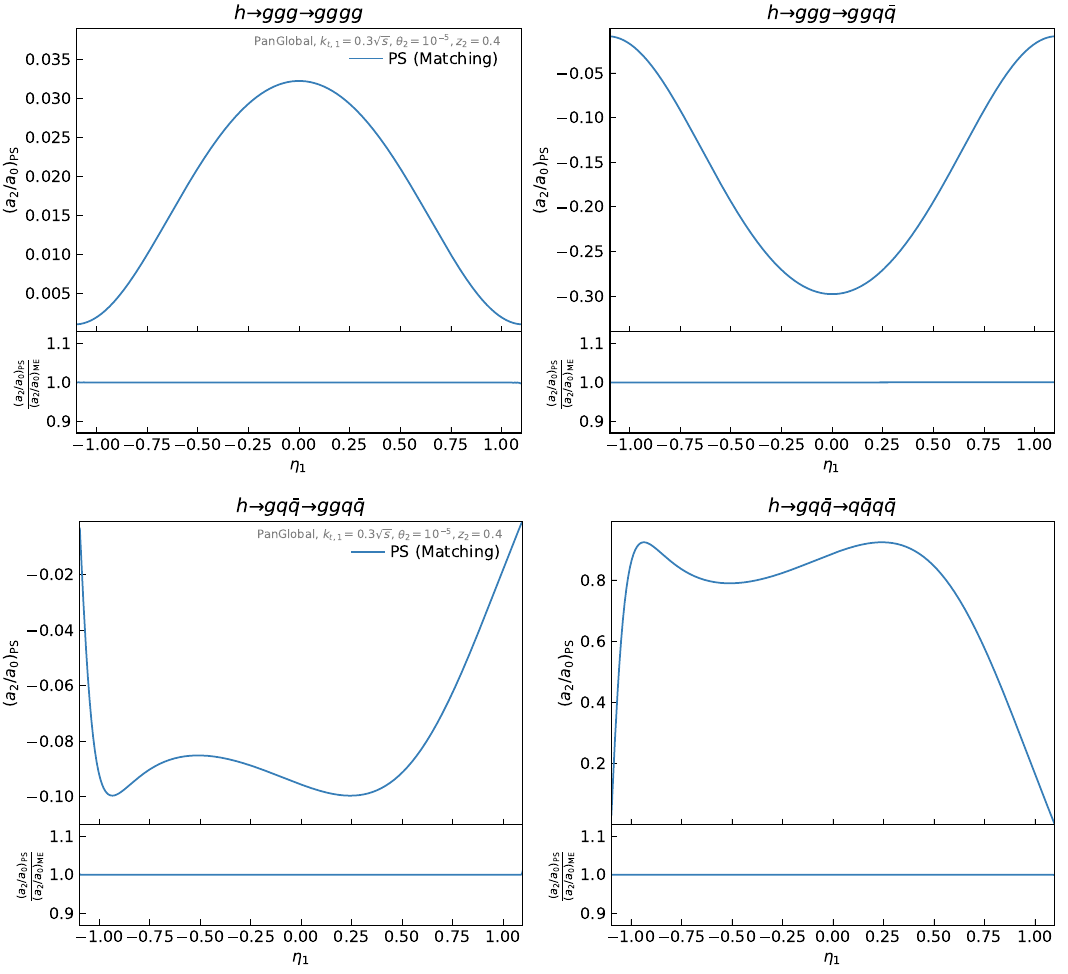
Figure 14. Same as figure 13, but for all possible configurations of H → gg . Note that in the lower plots, it is the gluon of the underlying 3-jet system that undergoes collinear splitting, rather than the hard emission from the 2-jet system (which is a quark or anti-quark, and so does not mediate azimuthal correlation). This is also the reason for the lack of symmetry in the matched result between positive and negative η 1